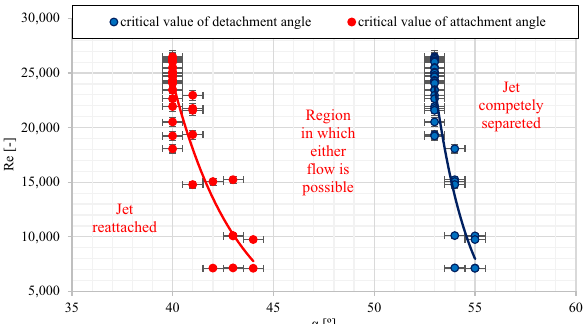
Figure 4. The range of occurrences for the hysteresis of the Coanda effect—critical values of the α D detachment angle and the α A reattachment